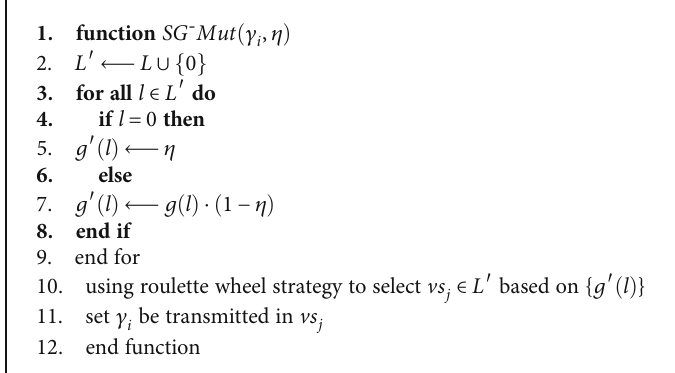
Algorithm 2: The stochastic greedy heuristic operation